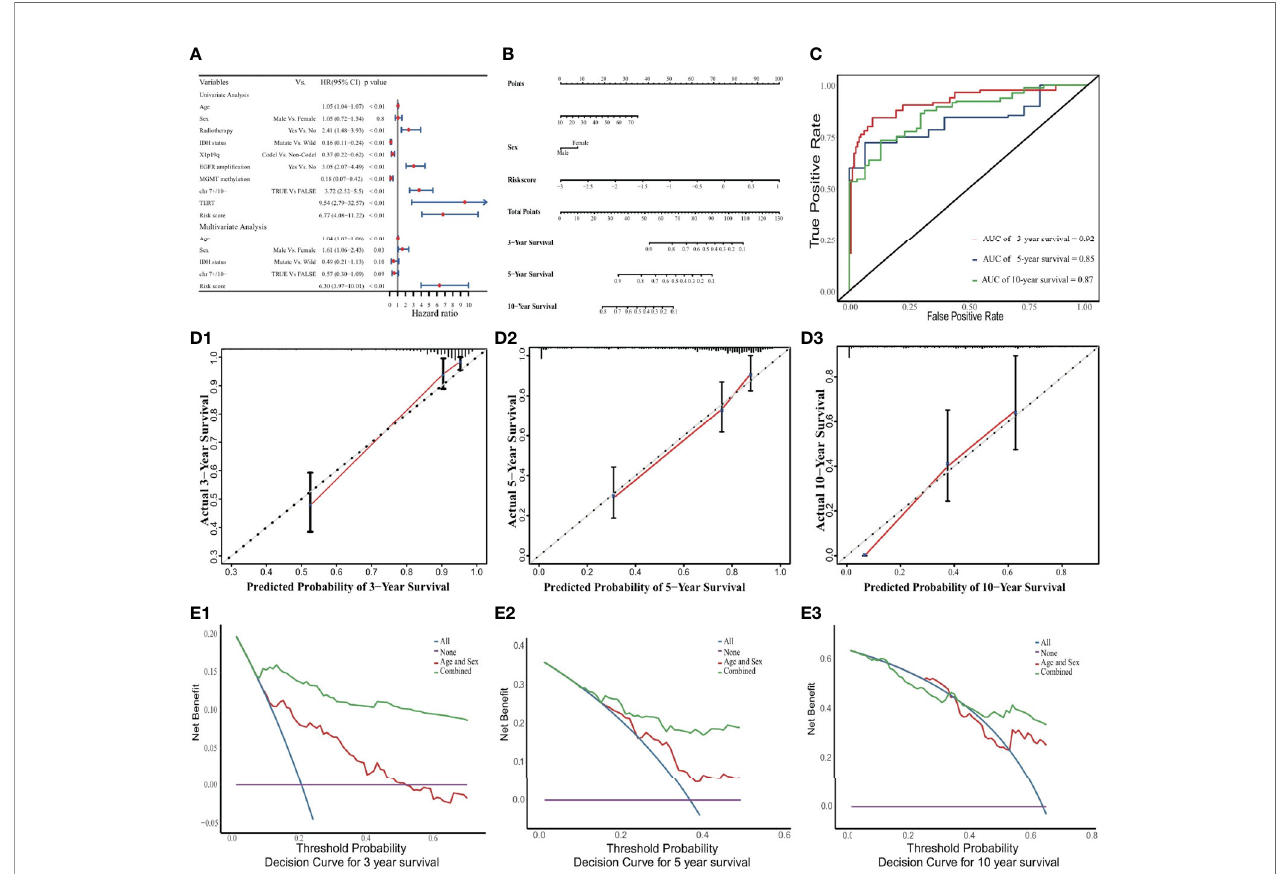
FIGURE 3 | Nomogram to predict 3-, 5, and 10-year OS. (A) Univariate and multivariate Cox analyses. The limitation of CI is de fi ned by the arrow symbols. (B) Nomogram to predict the 3-, 5- and 10-year OS for LGG patients. (C) Time-dependent ROC curves for 3-, 5- and 10-year OS prediction. (D) Calibration curves of 3-, 5- and 10-year OS. The black diagonal lines represent the ideal performance in predicting OS, and the red lines represent the actual performance. (E) The DCA